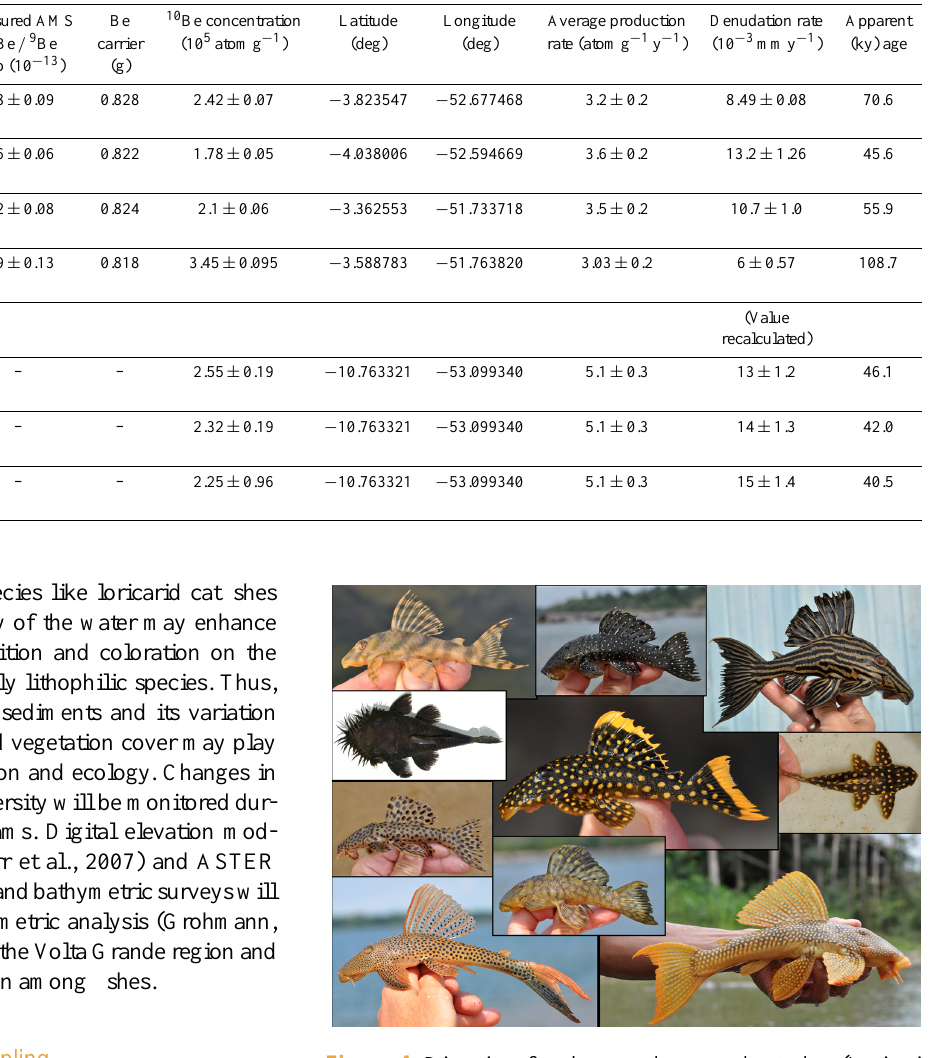
Figure 4. Diversity of sucker mouth armored catfishes (Loricari- idae) in the Xingu River, with emphasis on lithophilous species. Clockwise from upper left: Peckoltia vittata , Parancistrus nudiven- tris , Panaque armbrusteri, Scobinancistrus sp., Scobinancistrus au- reatus , Squaliforma sp., Leporacanthicus heterodon , Ancistrusra- nunculus . Center upper: Baryancistrus xanthellus . Center lower: Spectracanthicus